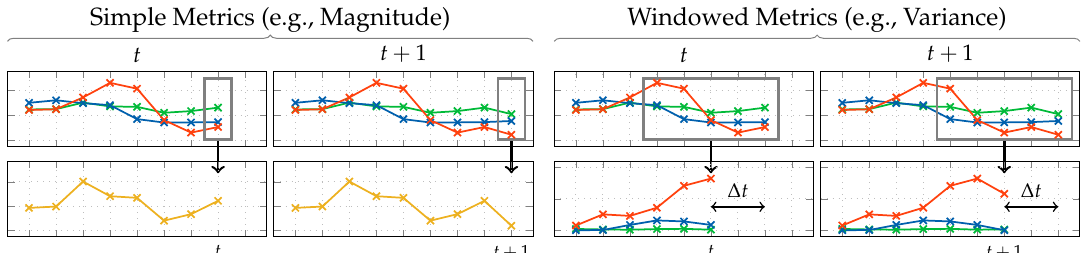
Figure 5. Calculation of virtual sensors for simple and windowed metrics at the example of magnitude and variance, simulated for two consecutive time-steps. For a window size of w virt , windowed metrics have a delay of ∆ t = w virt − 1 , while simple metrics such as magnitude always have a delay of ∆ t = 0. 2 Table 1. Overview of the metrics calculated as virtual sensors for the approach based on analytical transformations. For each metric, the table lists whether it is calculated on accelerometer, gyroscope, using a window, if it is calculated per sensor channel, as well as the resulting